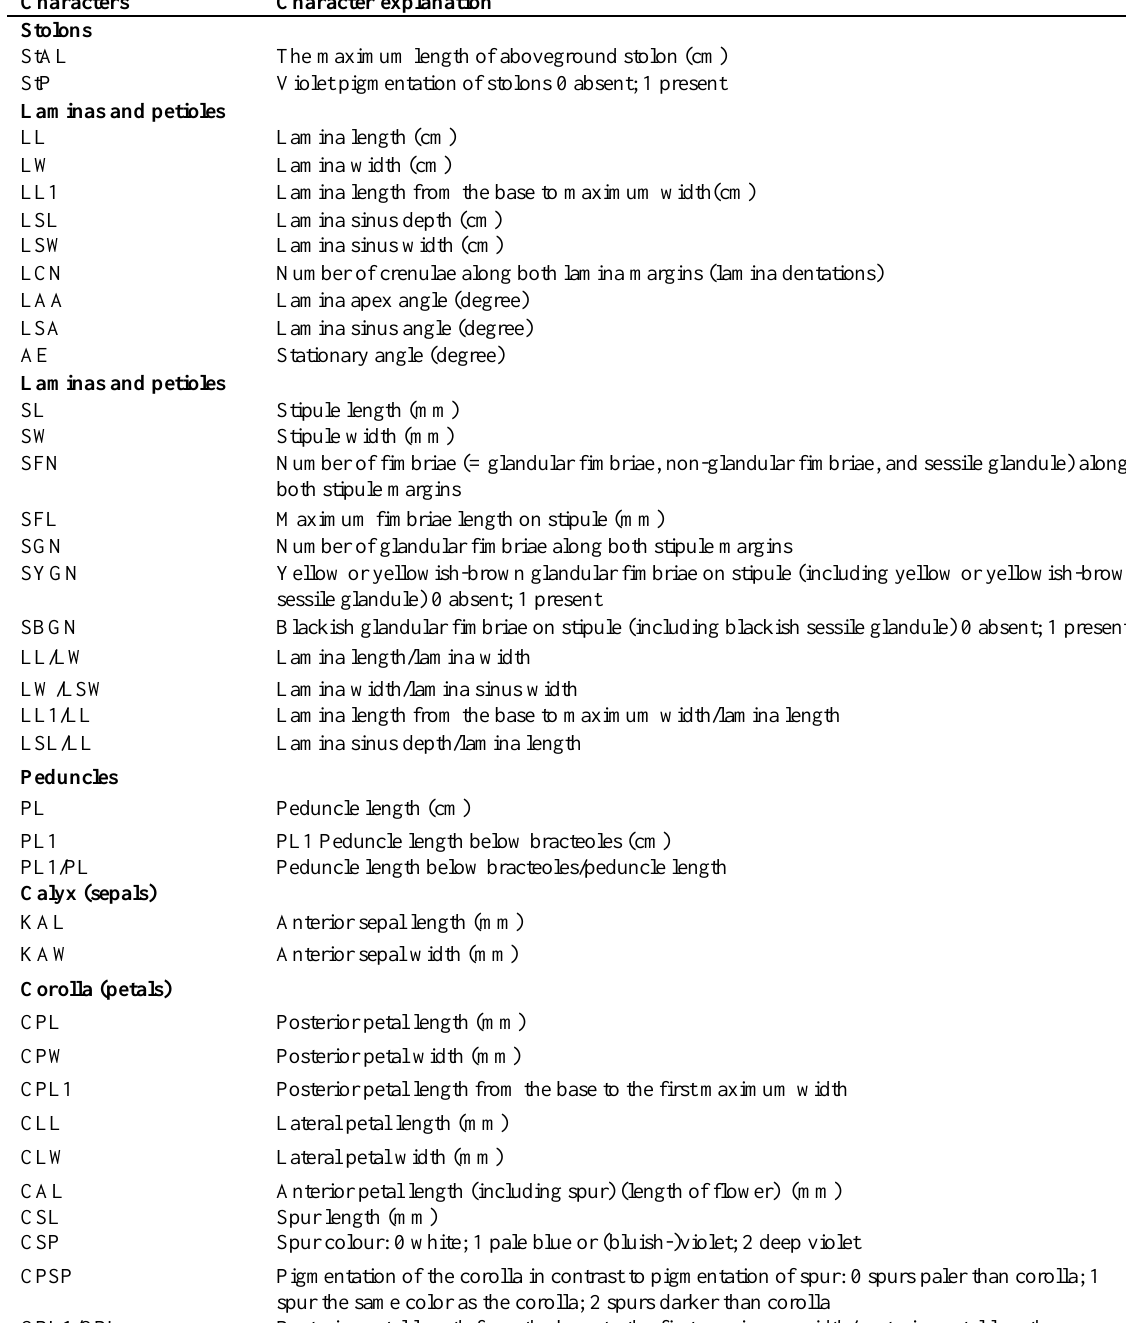
Table 2. Characteristics studied in violet populations